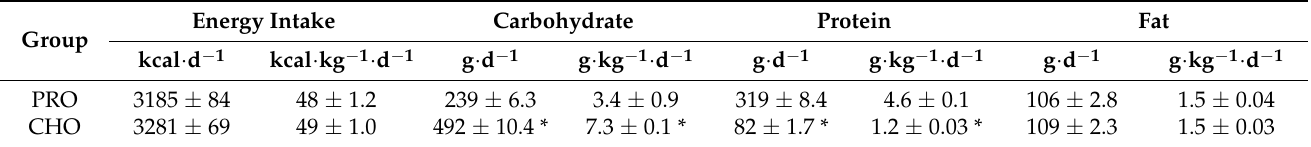
Table 2. Calculated mean dietary intake and macro-nutrient breakdown for each group during the 7-day intervention. Energy Intake Carbohydrate Protein Fat Group kcal · d − 1 PRO 3185 ±